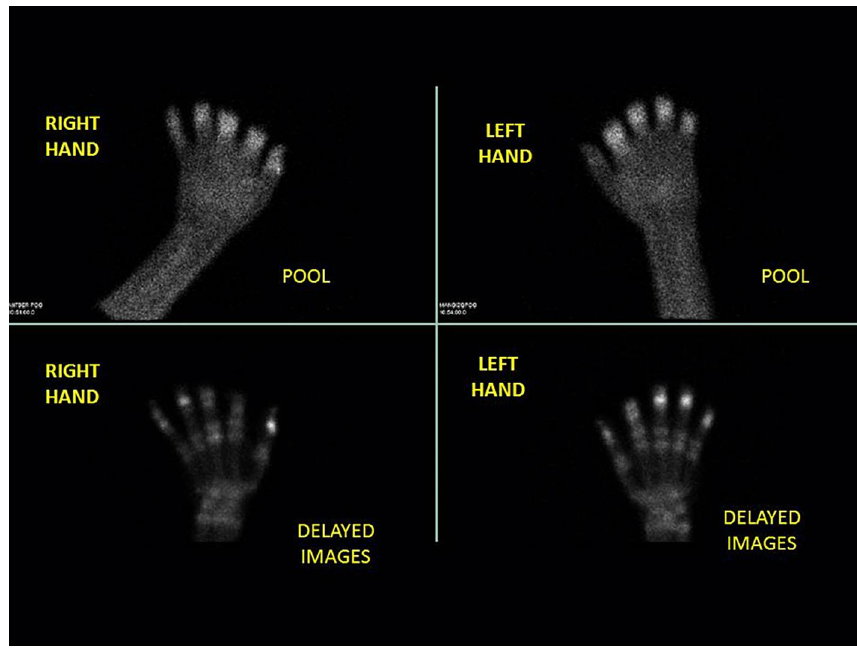
Fig. 3 Multiphase 99mTc-MDP bone scintigraphic. Multiphase 99mTc-MDP bone scintigraphic images of the hands show palmar soft tissue phase (above) and 4-h delayed phase